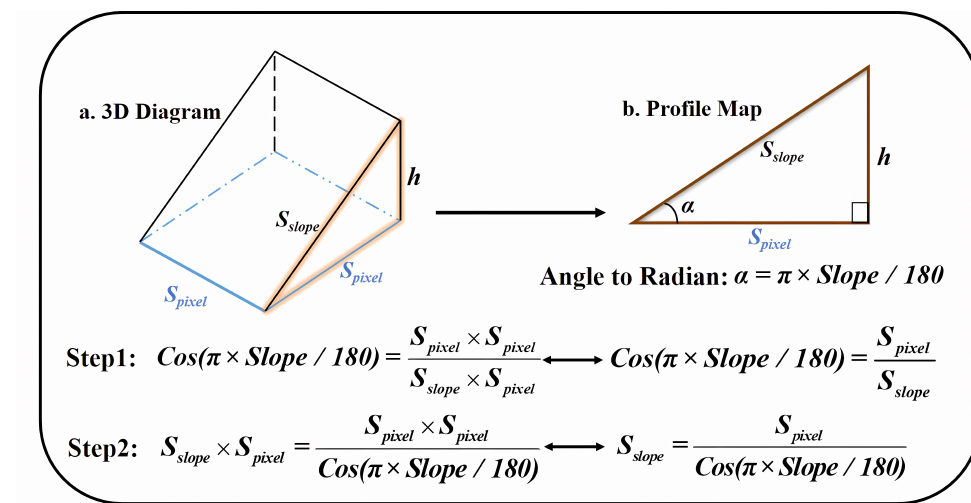
Figure 4. The flow of equation derivation for the curved